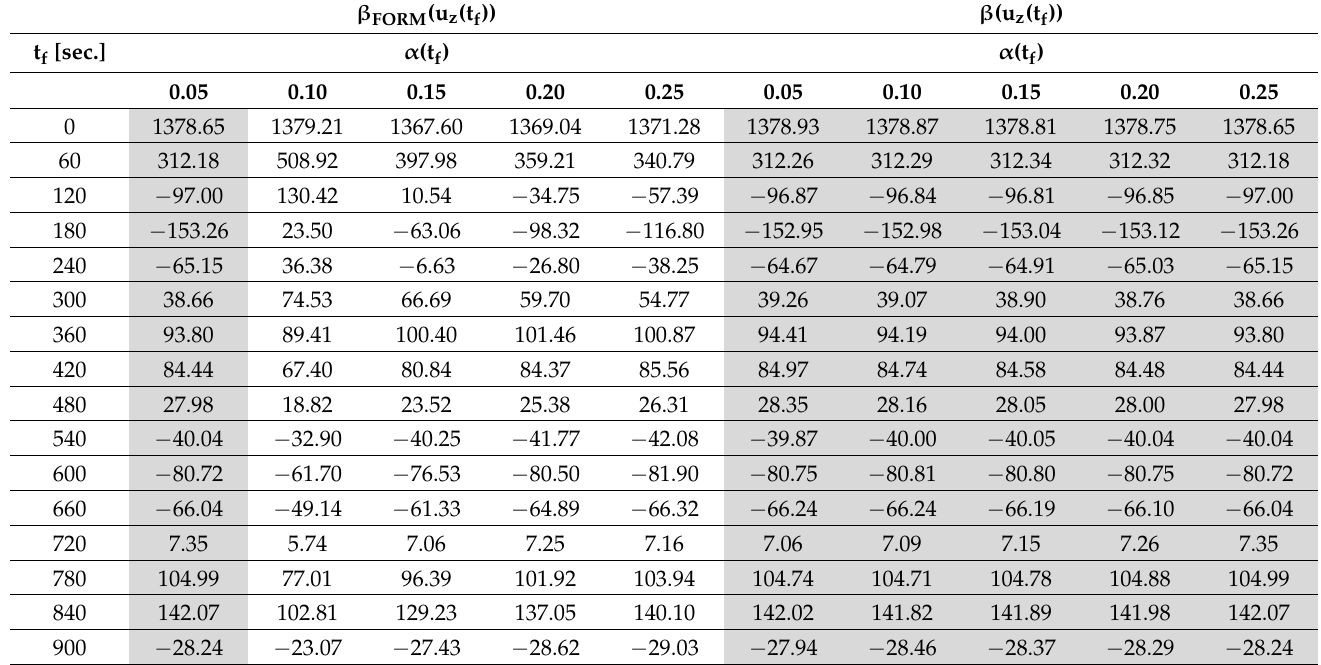
Table 1. Reliability index for the vertical displacements as a function of fire duration values compari- son for the FORM theory and the relative entropy